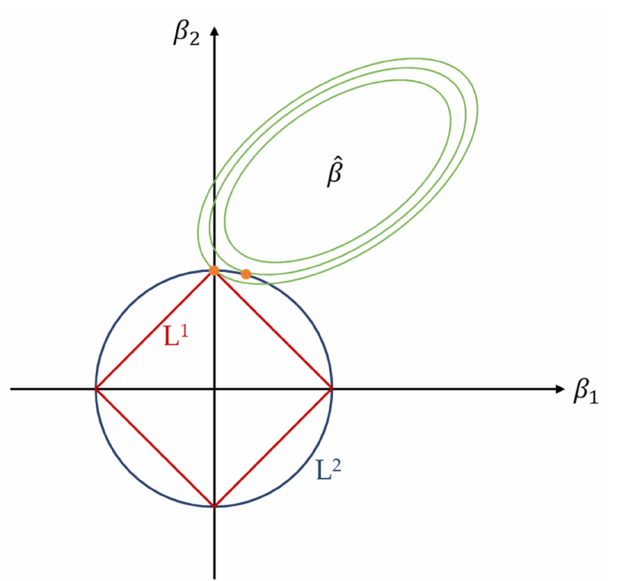
Figure 2. Least squares solution contour for a linear model with L 1 (red curve) and L 2 (blue curve) regularizations. Based on